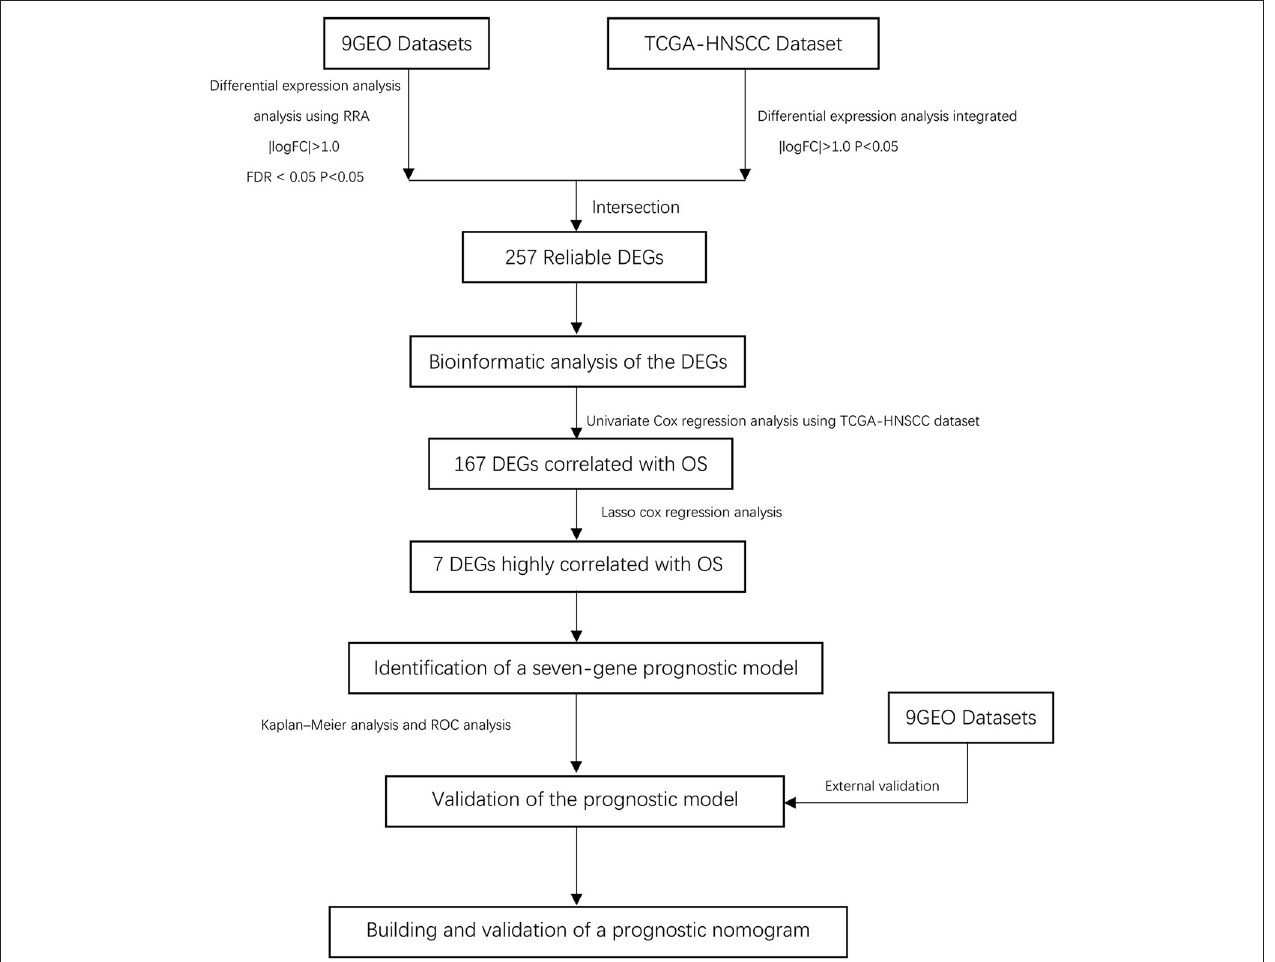
FIGURE 1 | Overall flowchart of this